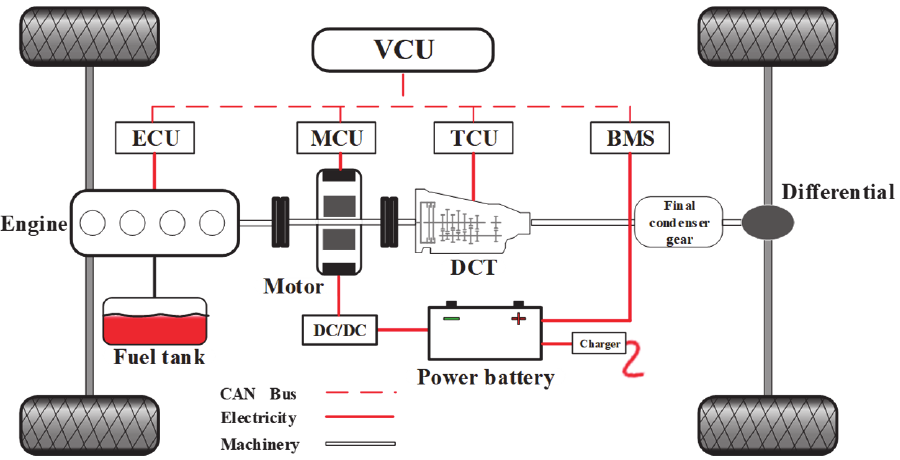
Figure 1. Parallel plug − in hybrid electric vehicle (PHEV) power system.